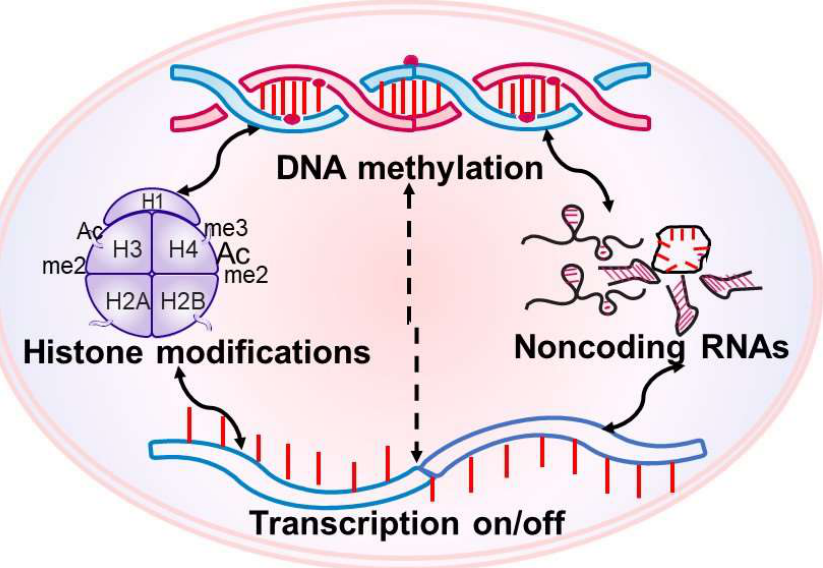
Figure 2. Epigenetic modifications are interrelated; DNA methylation can regulate histone modifying enzymes and can also regulate noncoding RNAs. Noncoding RNAs can regulate the machinery essential for DNA methylation and histone modifications.